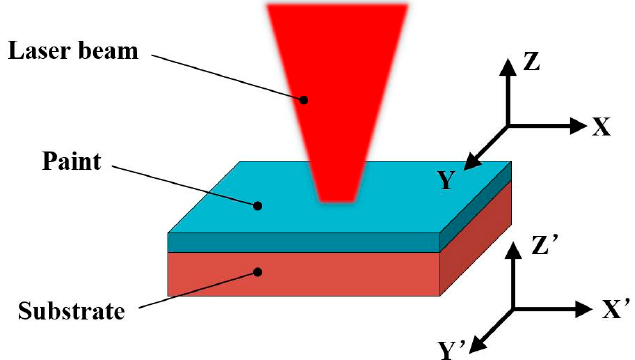
Figure 2. Simplified schematic diagram of paint removal by laser.